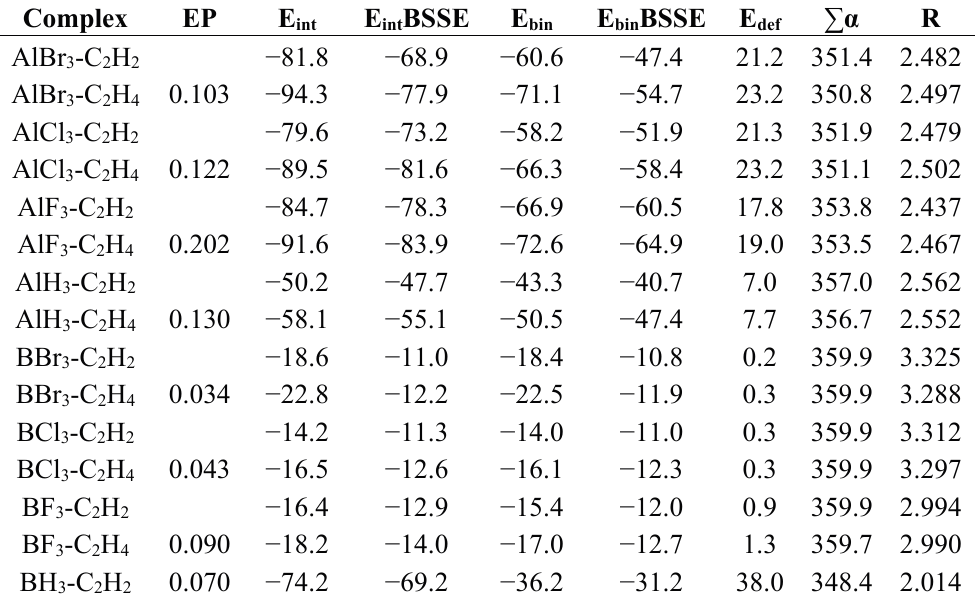
Table 1. The energetic parameters (in kJ/mol), the mean triel-carbon distance, R (in Å), and the ∑α parameter (in degrees), E int BSSE and E bin BSSE are E int and E bin energies corrected for BSSE; the maximum electrostatic potential (EP) for ZH 3 and ZX 3 monomers is